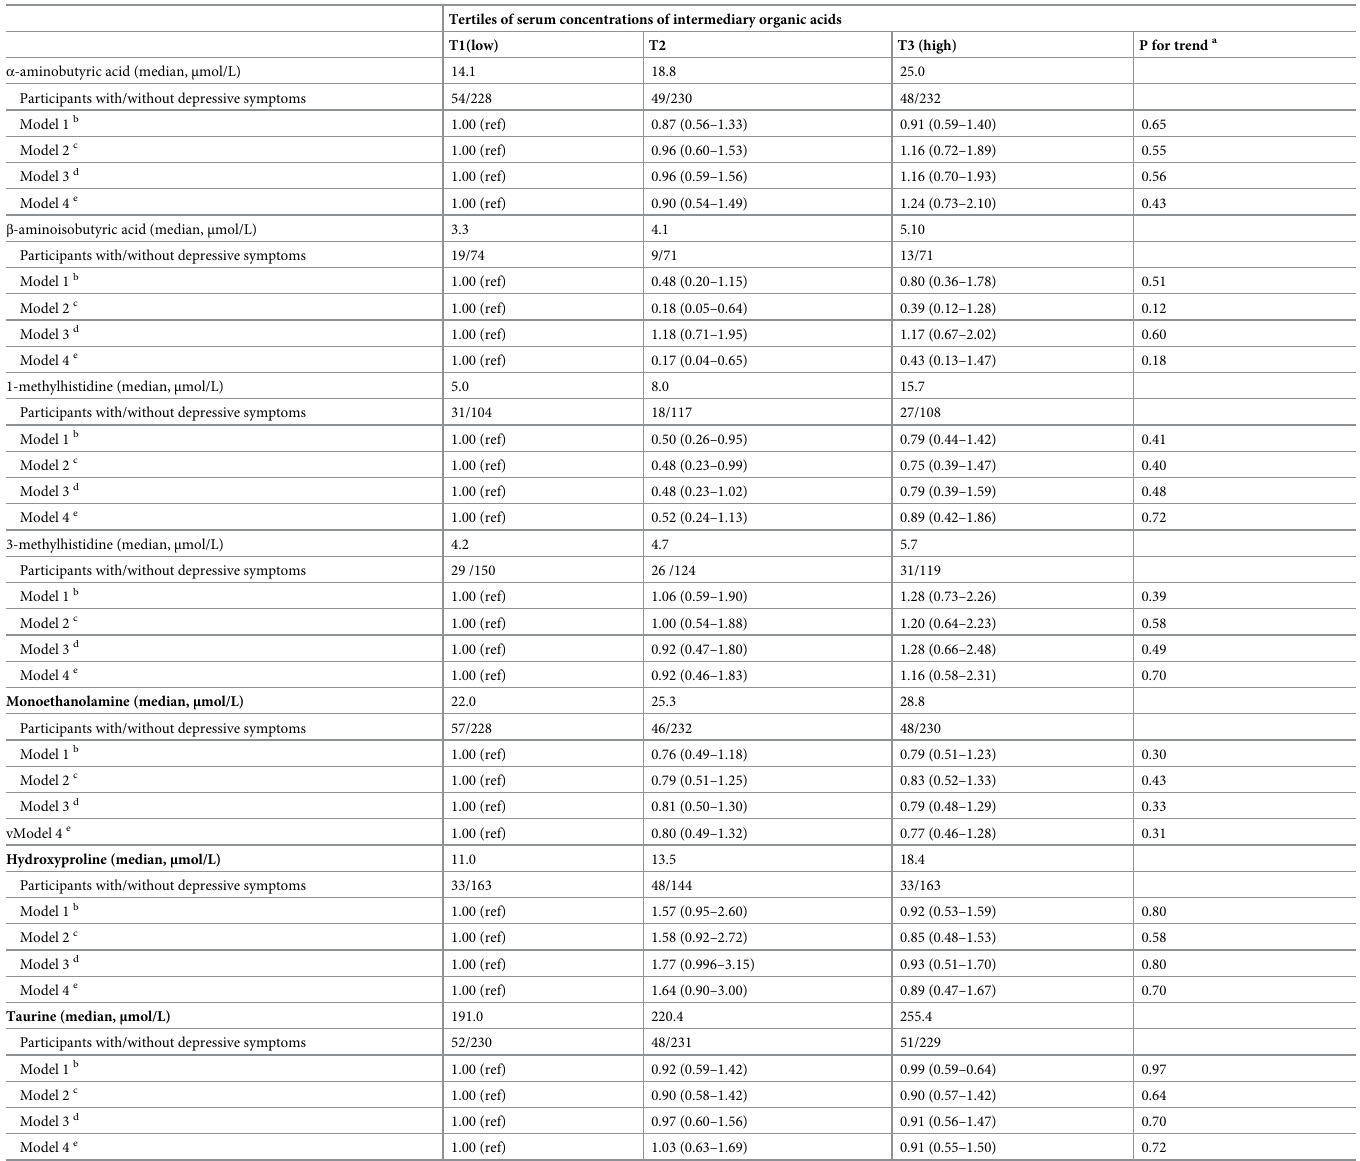
Table 5. Associations of intermediary organic acids with depressive